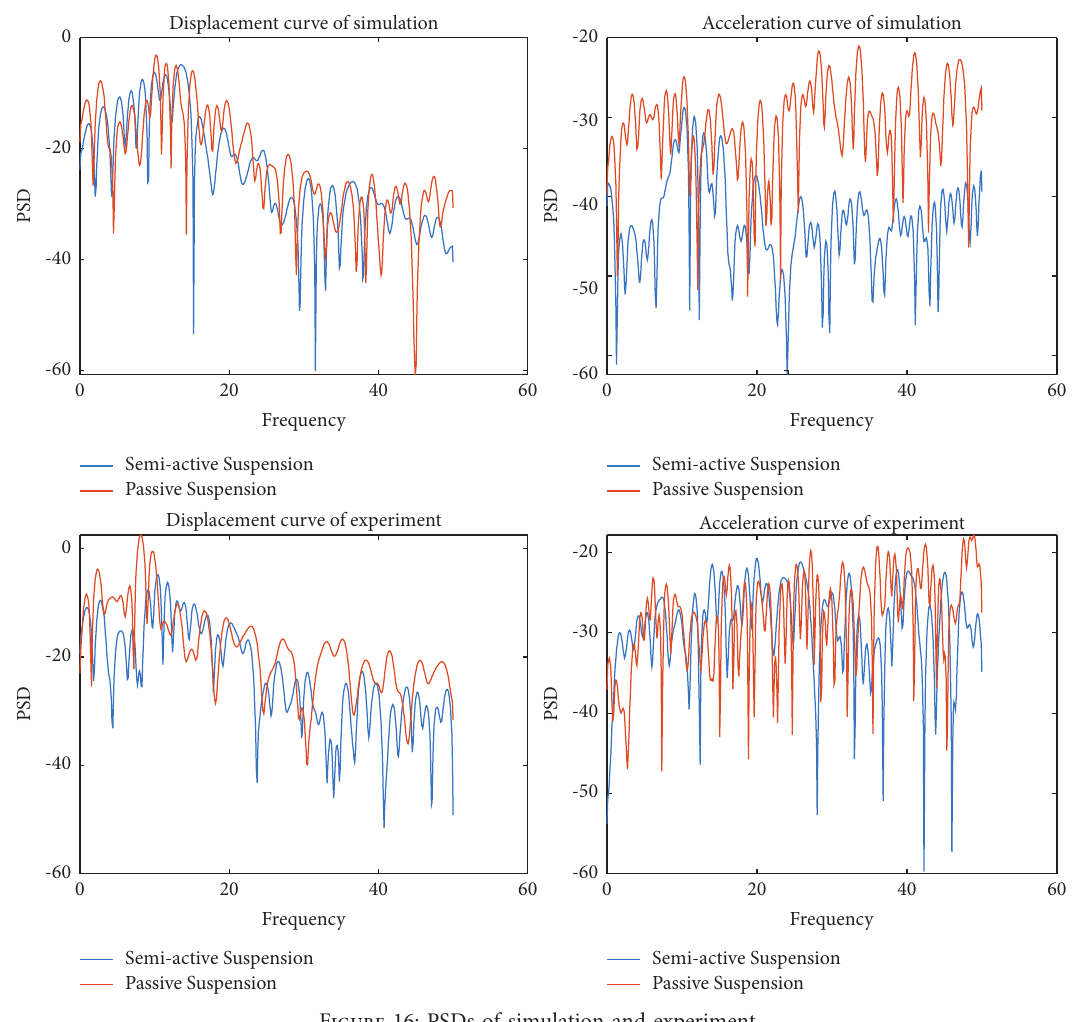
Figure 16: PSDs of simulation and experiment.